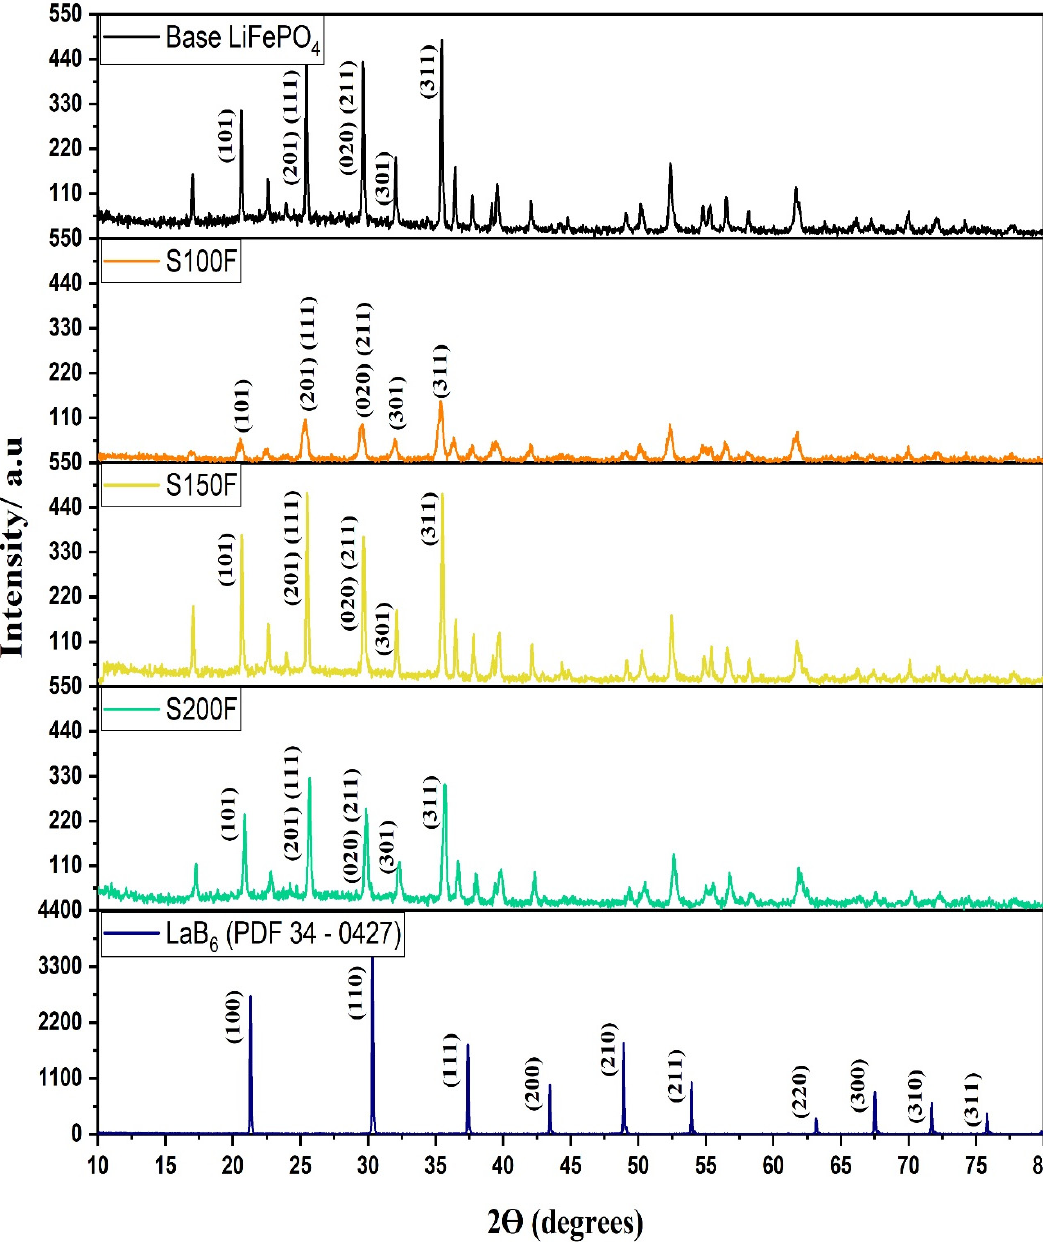
Figure 7. XRD patterns of synthesized Base LiFePO 4 vs. S150F. The LaB 6 sample (blue line) was used as the benchmark to determine the instrumental broadening.